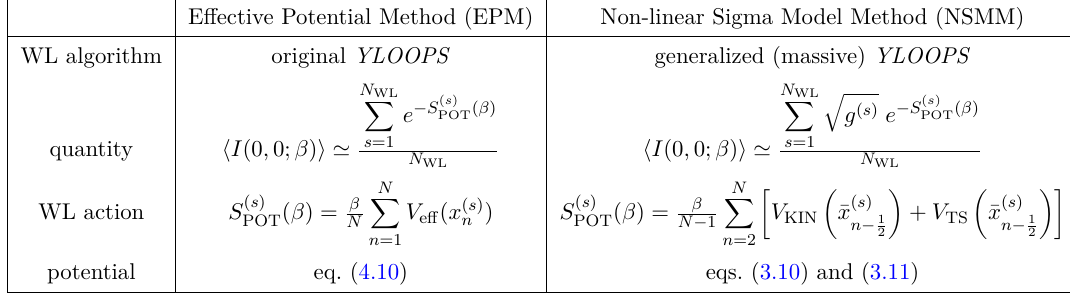
Table 1 . Details of the two types of computation performed for the same heat kernel expansion, with a linear sigma model and with a non-linear sigma model